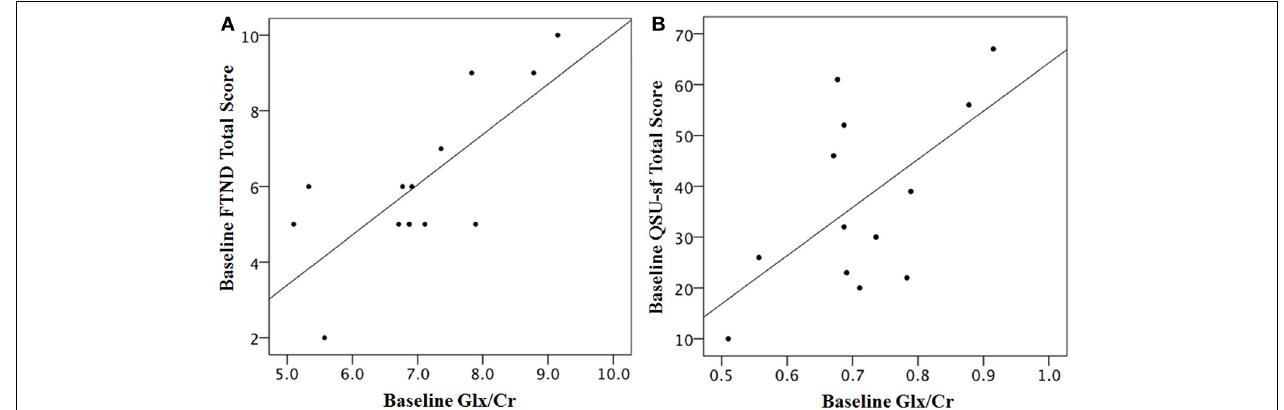
FIGURE 3 | Baseline scales of nicotine dependence (FTND) and nicotine craving (QSU-sf) correlate with baseline dACC Glx/Cr. (A) Correlation of Fagerström Test for Nicotine Addiction (FTND) and Glx/Cr: R 2 = 0 . 558, Pearson r = 0 . 747, p = 0 . 002 two-tailed, significant after Bonferroni Correction (B) Questionnaire of Smoking Urges Short Form (QSU-sf),